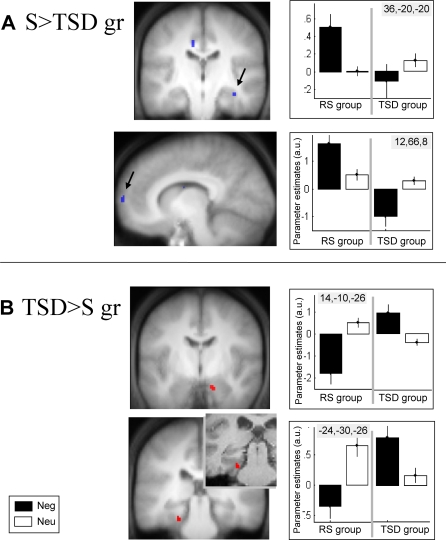
Effect of Sleep on Emotional (Negative) Memory(A) Memory (R > K) × emotion (Neg > Neu) × sleep status (RS > TSD) interaction. From the top to the bottom: the hippocampus and the medial prefrontal cortex.(B) Memory (R > K) × emotion (Neg > Neu) × sleep status (TSD > RS) interaction. From the top to the bottom: amygdala and fusiform gyrus (inset: enlarged mesio-temporal region in a representative subject).Neu: neutral; Neg: negative. Left panels: functional results are displayed on the mean structural MR image, normalized to the same stereotactic space (display at p < 0.001, uncorrected). Right panels: parameter estimates of recollection minus familiarity (arbitrary units ± SEM).